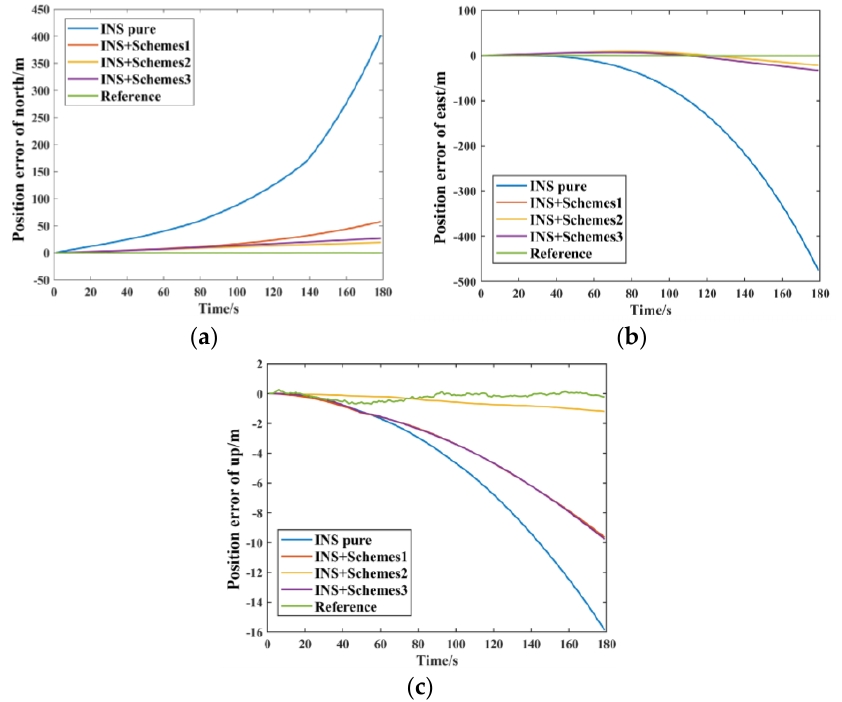
Figure 7. Positioning errors using different motion constraint schemes: ( a ) north direction; ( b ) east direction; ( c ) up direction.